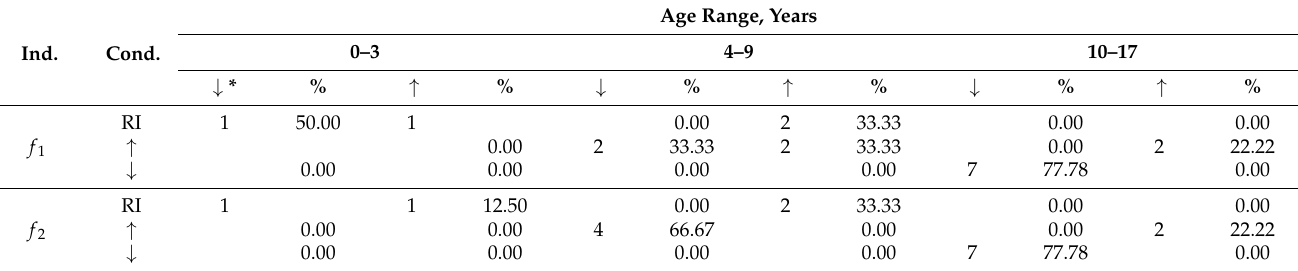
Table 5. Immunogram analysis for the state of the immune system k 3